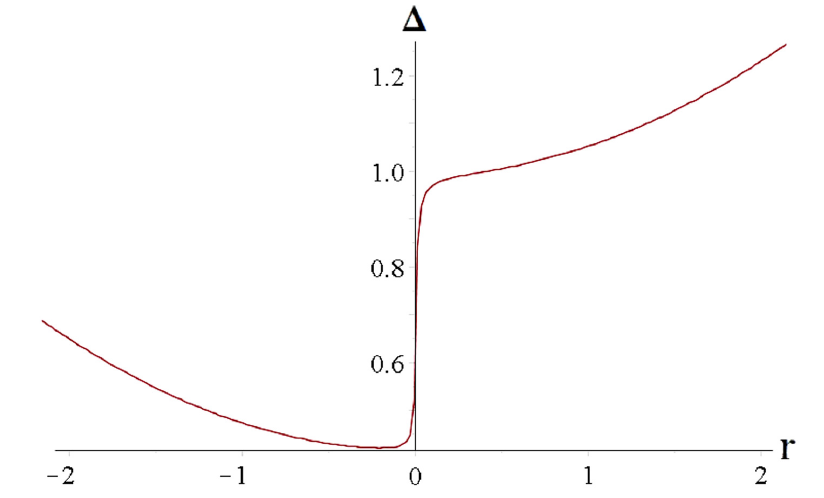
Figure 8. The metric function ∆ of the wormhole solution in a de Sitter universe, φ 0 = 24.5. Reproduced from